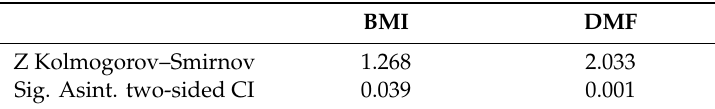
Table 6. Kolmogorov–Smirnov test for the sample.